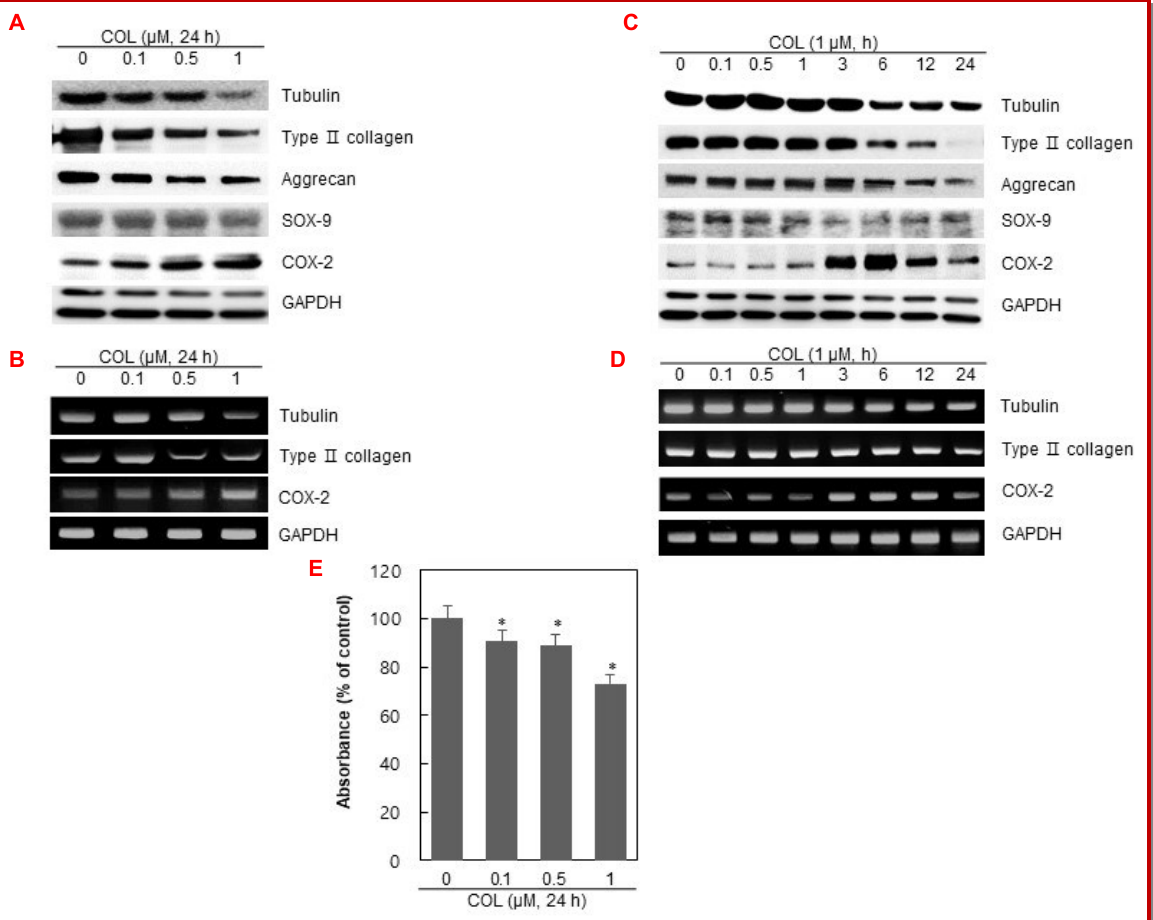
Figure 1: Colchicine reduces tubulin synthesis and chondrocytes differentiation and induces COX-2 expression in articular chon- drocytes Chondrocytes were either left untreated or given different doses of colchicine for 24 hours in (A and B). By using western blot (A) or RT-PCR, the expression levels of tubulin, type II collagen, aggrecan, SOX-9, COX-2, and glyceraldehyde-3-phosphate dehydrogenase (GAPDH) were examined (B). GAPDH was used as a loading control. (C and D) For 24 hours, chondrocytes were either left untreated or given different doses of colchicine. By using western blot (C) or RT-PCR, the expression levels of tubulin, type II collagen, aggrecan, SOX-9, COX-2, and GAPDH were examined (D). GAPDH was used as a loading control. (E) For 24 hours, chondrocytes were either left untreated or given different doses of colchicine. Alcian blue staining was used to assess how sulfated proteoglycans were synthesized. The data in (A, B, C, D, and E) indicate the outcomes of a typical experi- ment, whereas the data in (E) represent mean values with standard deviation.